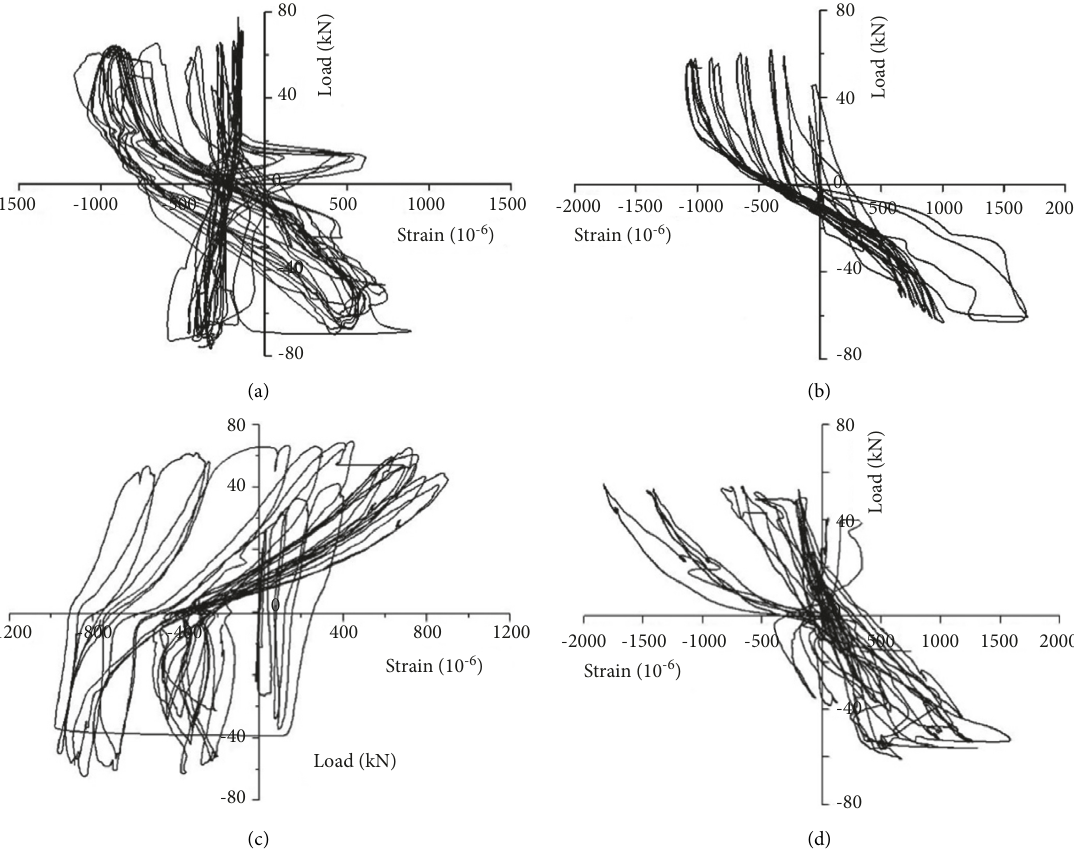
Figure 5: Load-strain curves of steel bars. (a) XJ1. (b) ZP1. (c) XJ2. (d)